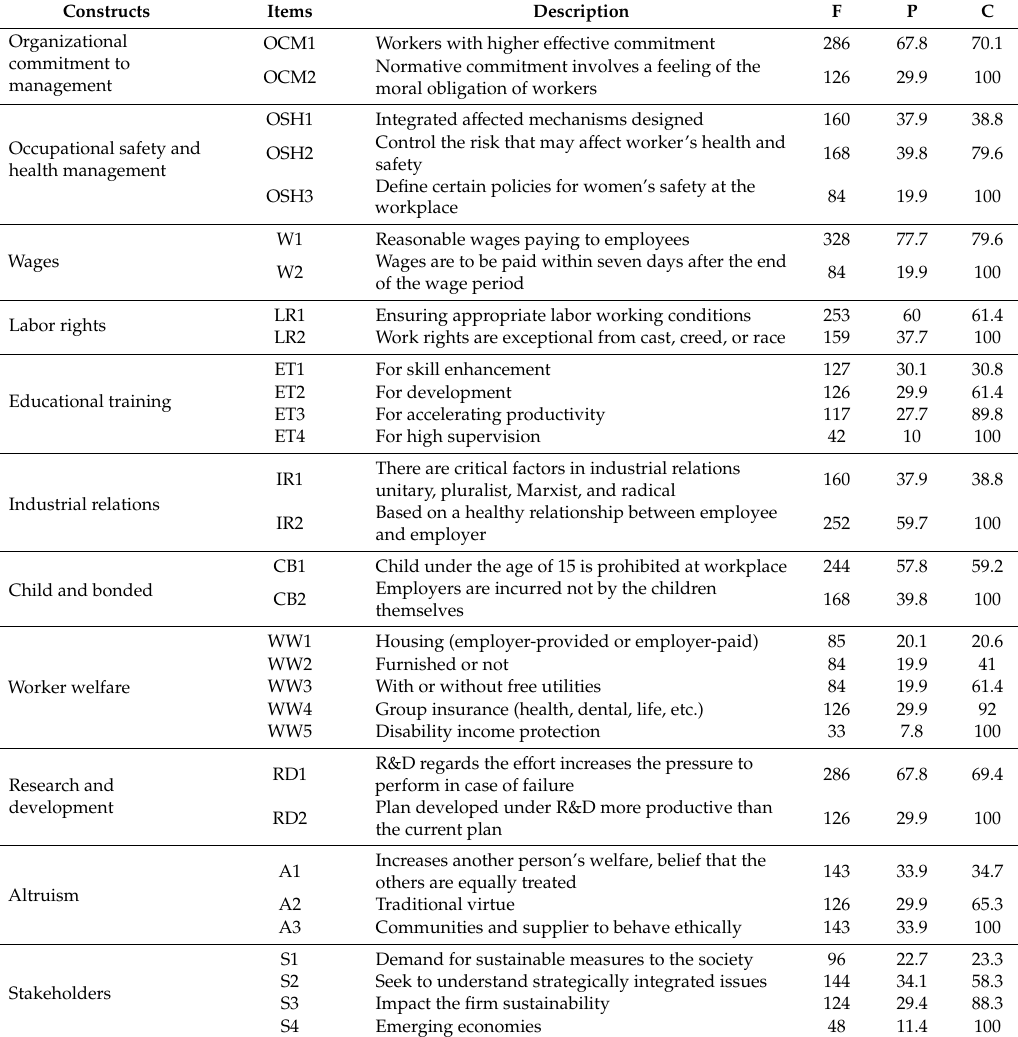
Table 4. Manufacturer social sustainable supply chain management